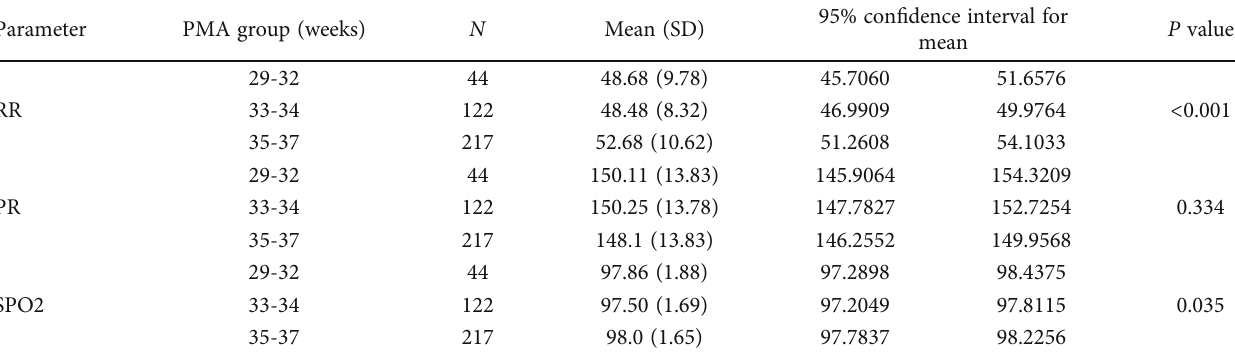
Figure 3: Mean SPO2 at di ff erent time points for all the feeding methods. Table 5: Vital parameters based on PMA